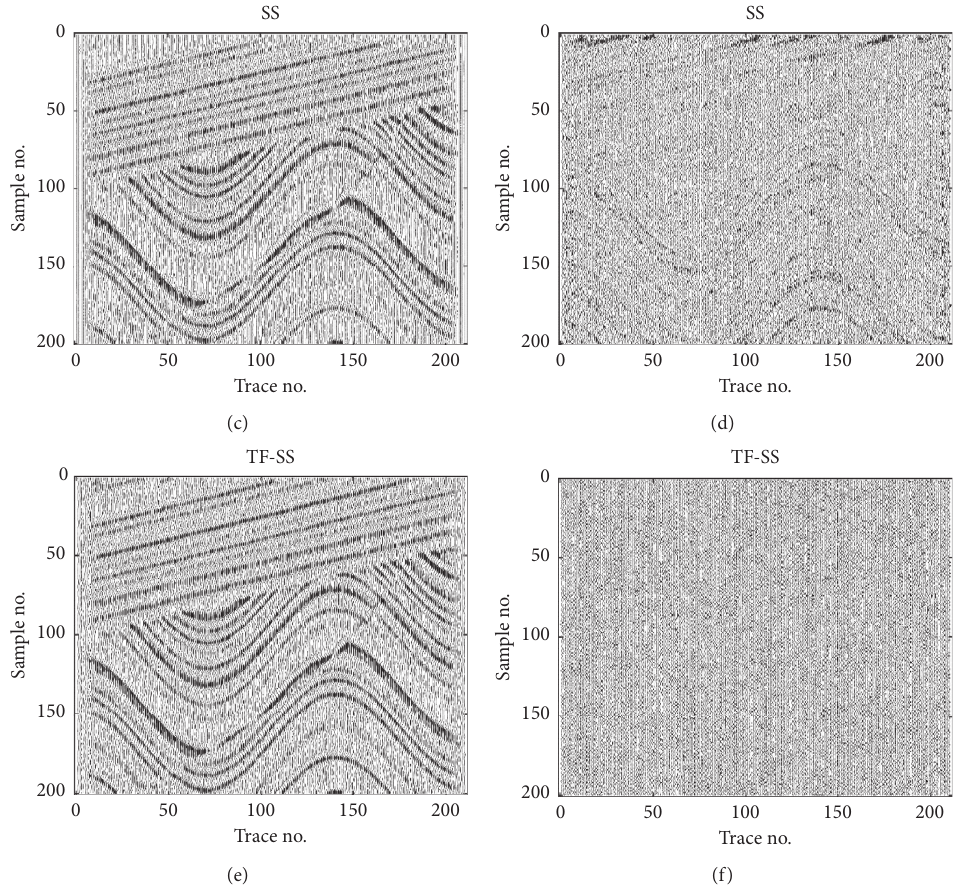
Figure 7: Denoising results of the sigmoid model with Gaussian white noise (S/R � 0dB). (a) Original seismic record. (b) Noisy seismic record. (c) Denoising by SS. (d) Noise removed by SS. (e) Denoised by TF-SS. (f) Noise removed by TF-SS.